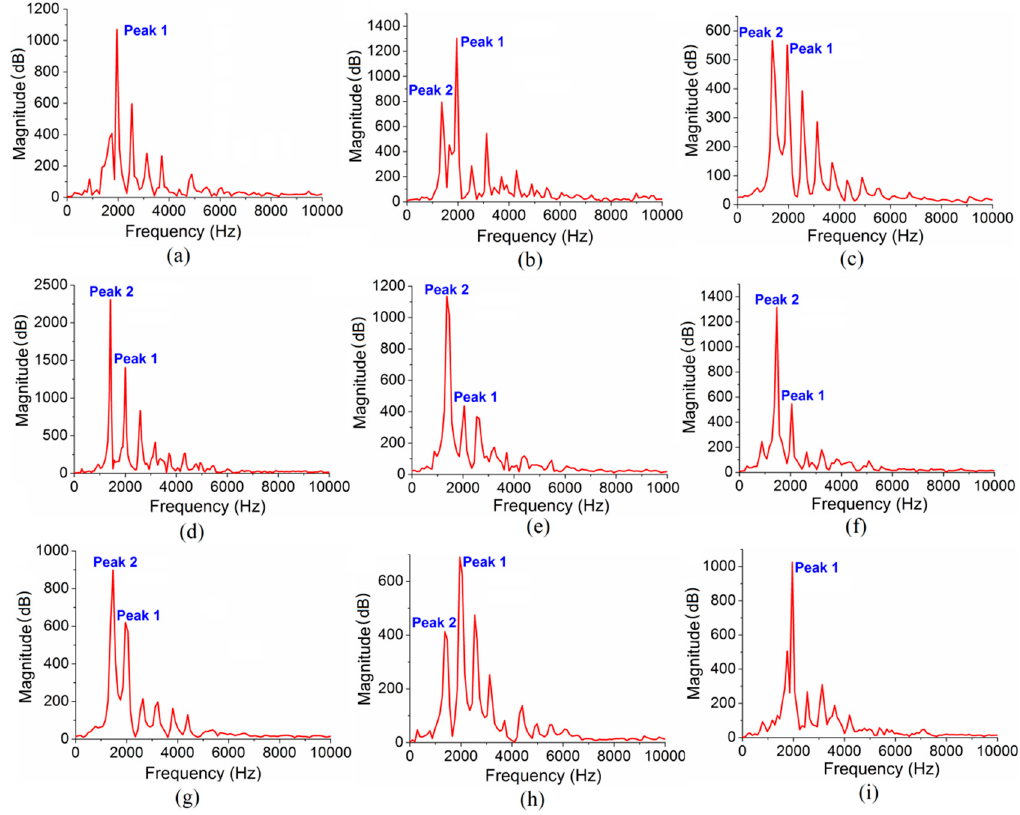
Figure 2. Frequency spectrum of freely vibrated poly(methyl methacrylate) (PMMA) beam (37 mm × 11 mm × 1.1 mm) during heating at ( a ) 25 °C; ( b ) 58 °C; ( c ) 75 °C; ( d ) 77 °C; ( e ) 82 °C; ( f ) 120 °C; and cooling at ( g ) 82 °C; ( h ) 65 °C; ( i ) 23 °C.